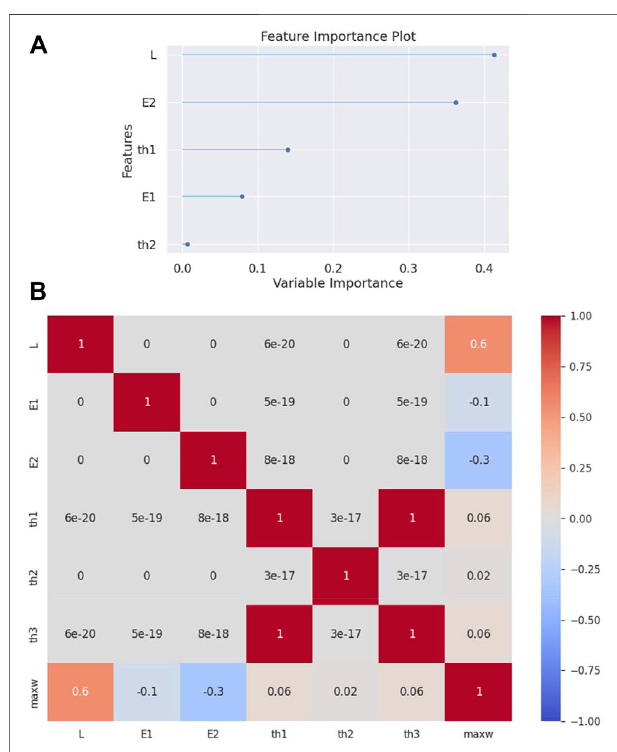
FIGURE 3 | (A) Feature importance plot and (B) correlation matrix heatmap for the simply supported beam.